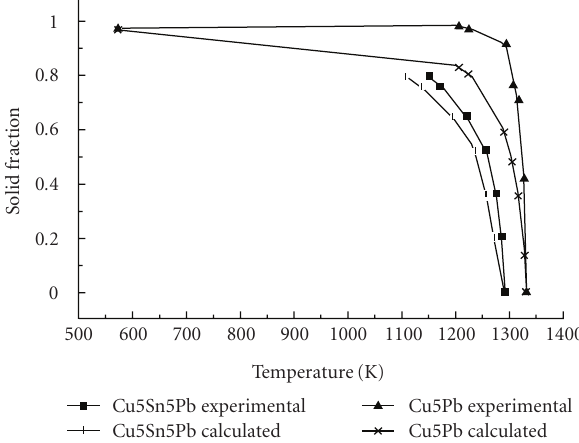
Figure 2: Experimental and calculated values of the solid fraction in Cu-5Pb and Cu-5Sn -5Pb